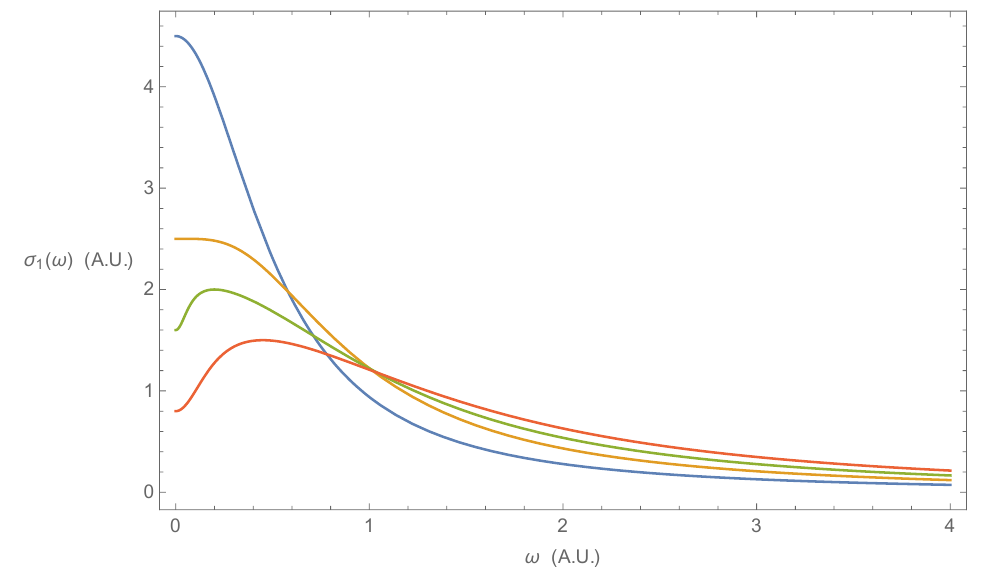
Figure 1: Illustrative plot of the temperature dependence of the optical conductivity of bad metals. As temperature is increased, the peak broadens and then moves off the ω = 0